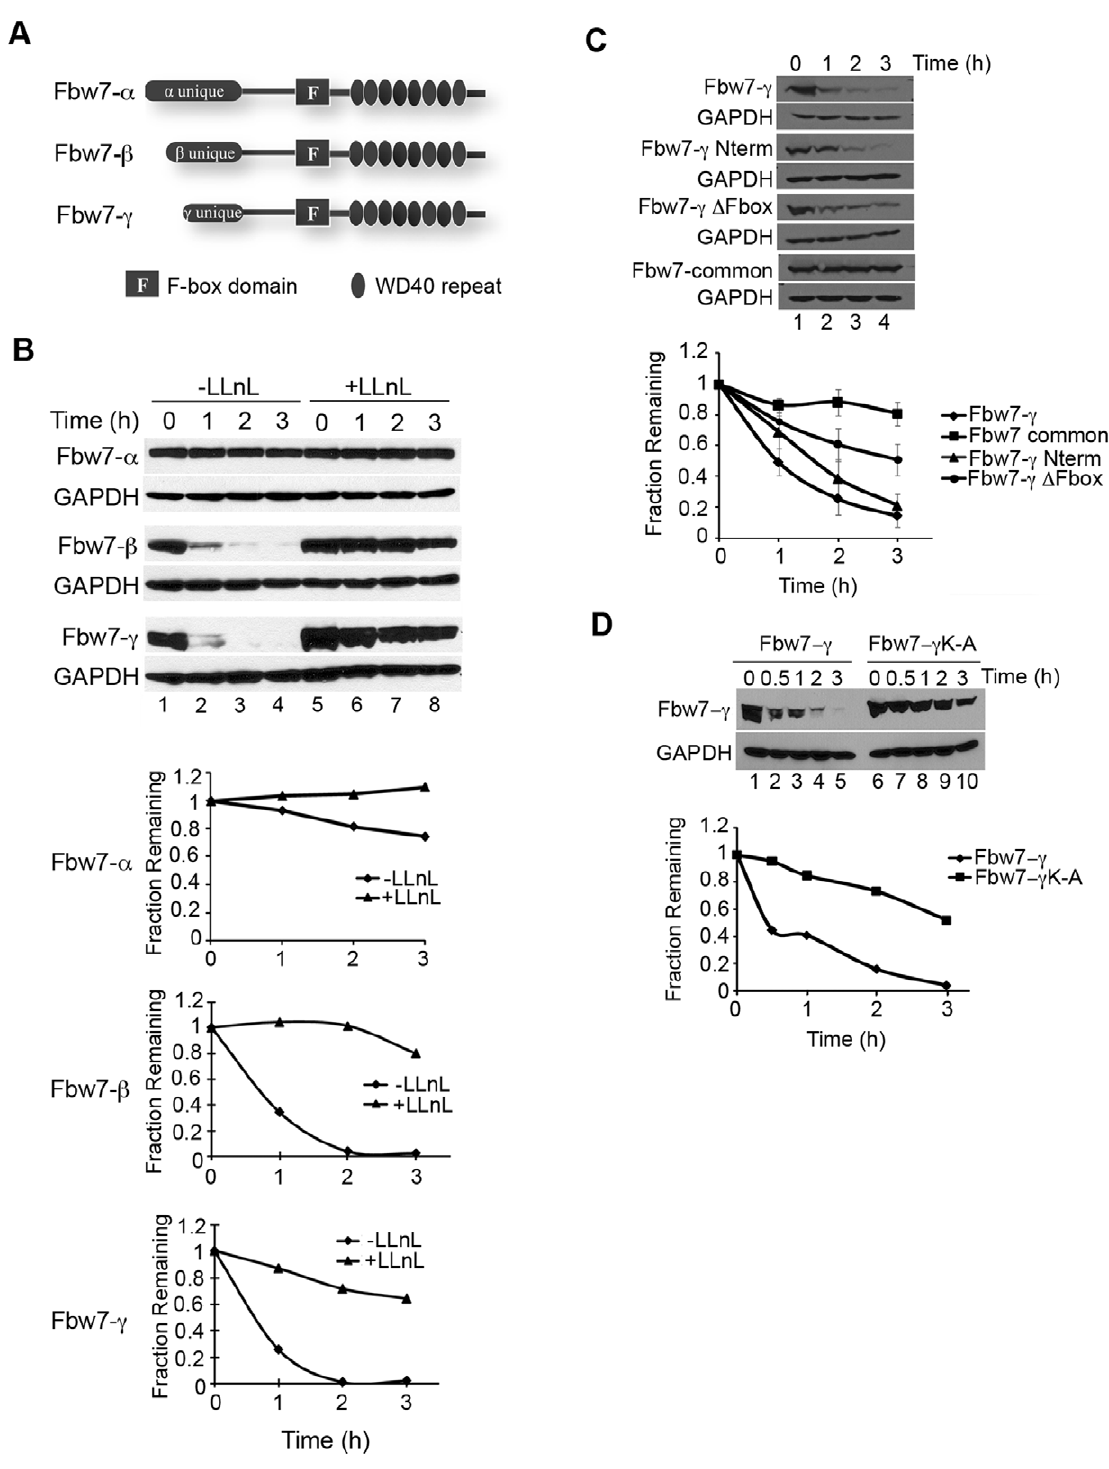
Figure 1. Fbw7- c is an unstable protein and its proteolysis is dependent on the proteasome. A) Diagram of Fbw7 isoforms. The F-box motif and WD40 repeats are marked as shown. B) Fbw7- b and c are unstable proteins, and their degradation is proteasome-dependent. Flag-tagged Fbw7 isoforms were expressed in HEK293T cells and protein stability assays were performed as described in Materials and Methods. Quantitation of a representative experiment is shown in the graph. C) The N-terminal unique region is critical for Fbw7- c degradation. Protein stability assays were performed as described in (B) with cells expressing the indicated Flag-tagged proteins. Quantitation of three independent experiments is shown on the graph. Error bars indicate standard deviations. D) The lysine residues within the unique region of Fbw7- c are critical for degradation. Protein stability assays were performed as described in (B) with cells expressing the indicated Flag-tagged proteins. Quantitation of a representative experiment is shown in the graph.